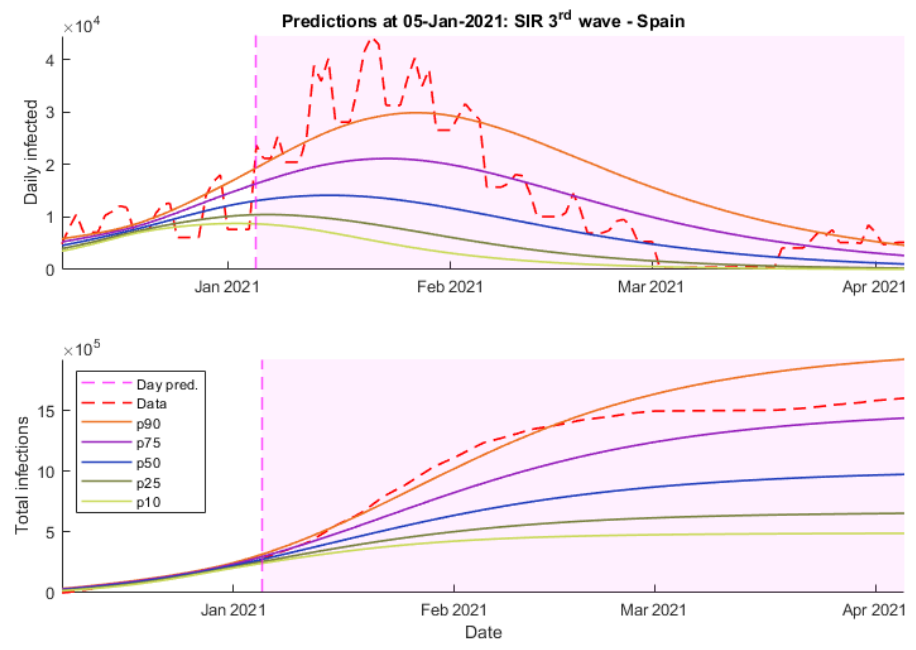
Figure 10. Predictions 5 January 2021 wave 3 SIR — Spain.